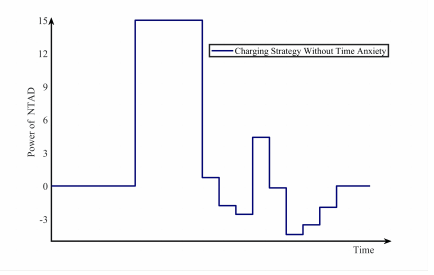
Figure 9. The time anxiety impact of NTAD.